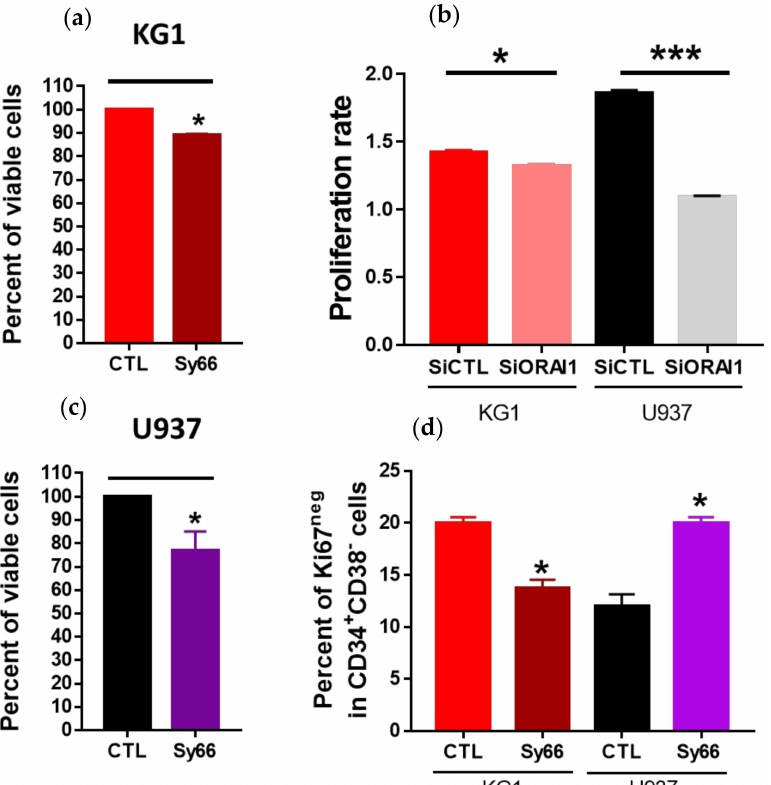
Figure 6. SOCs/ORAI1 are involved in proliferation of KG1 and U937 cells and in the quiescence state of LSC. KG1 ( a ) and U937 ( c ) viability (Trypan blue) under control conditions or after 24 h of treatment with synta66 (10 µ M). ( b ) Proliferation rate of KG1 and U937 cells transfected with control or ORAI1 siRNA. ( d ) Percentage of Ki67 neg cells in CD34 + CD38 − LSCs treated or not treated for 24 h with synta66 (10 µ M). For each experiment, three independent experiments were performed. *** p ≤ 0.001. * p ≤